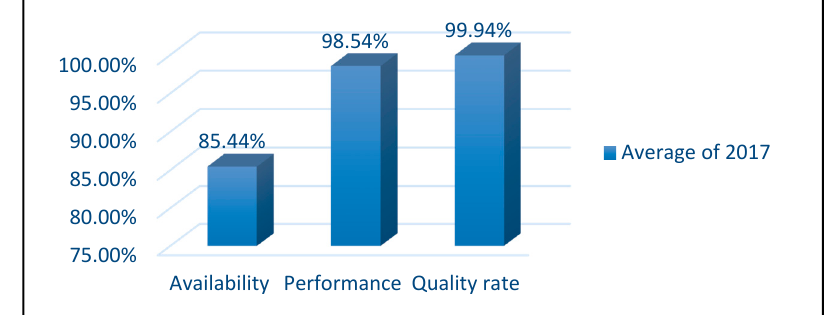
Figure 9. OEE factors in 2017.